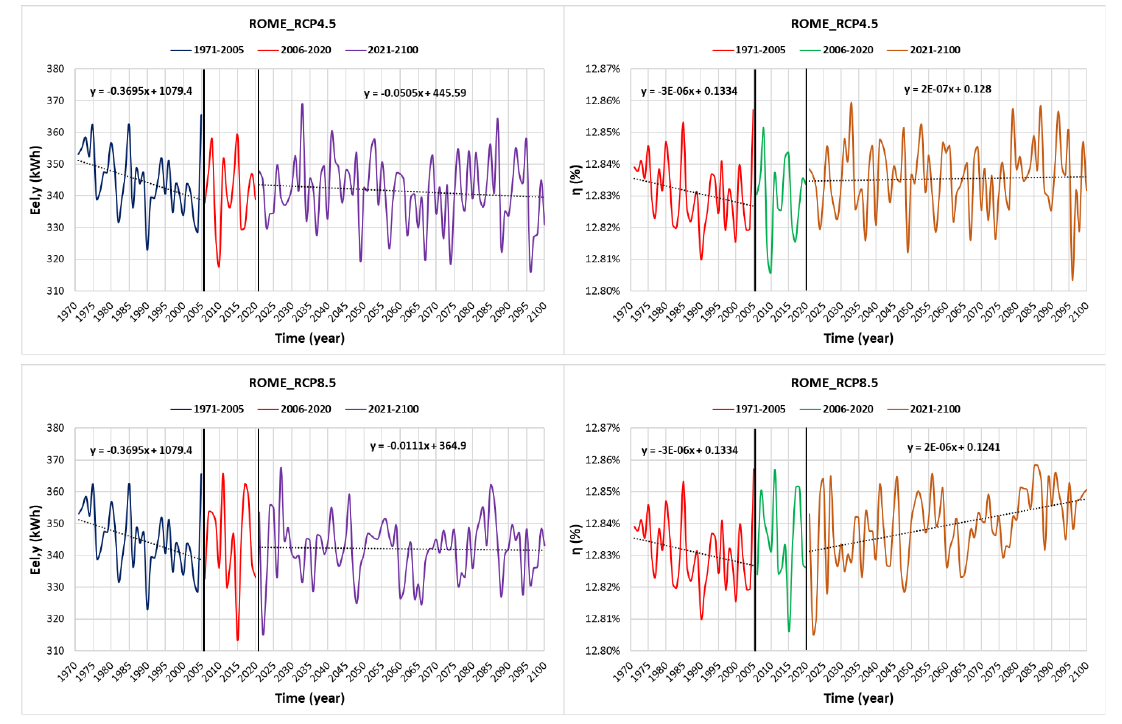
Figure 8. Rome ’ s yearly PV electricity variation ( left ) and yearly PV efficiency variation ( right ) from 1971 to 2100. ( Top ): RCP4.5, ( bottom ): RCP8.5.